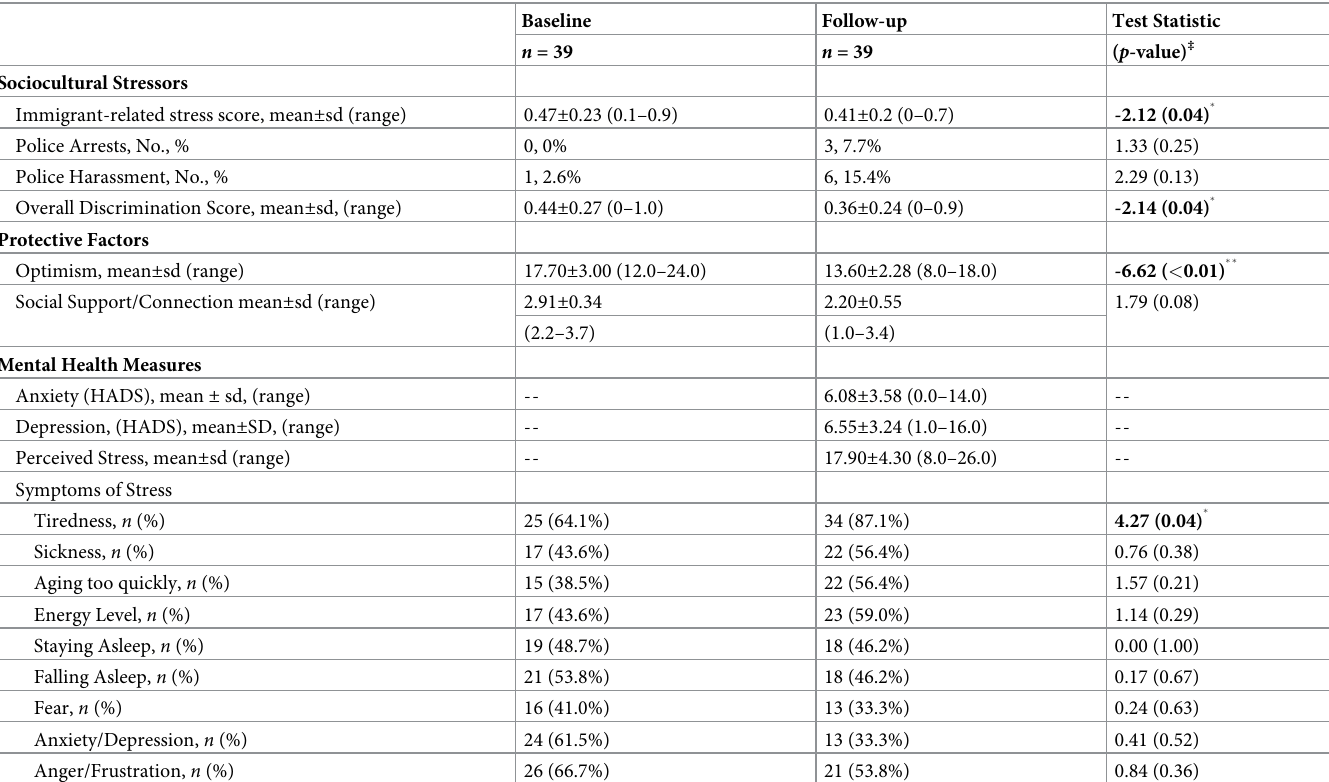
Table 2. Changes in sociocultural stressors, protective factors, and mental health measures in the interior city from baseline to